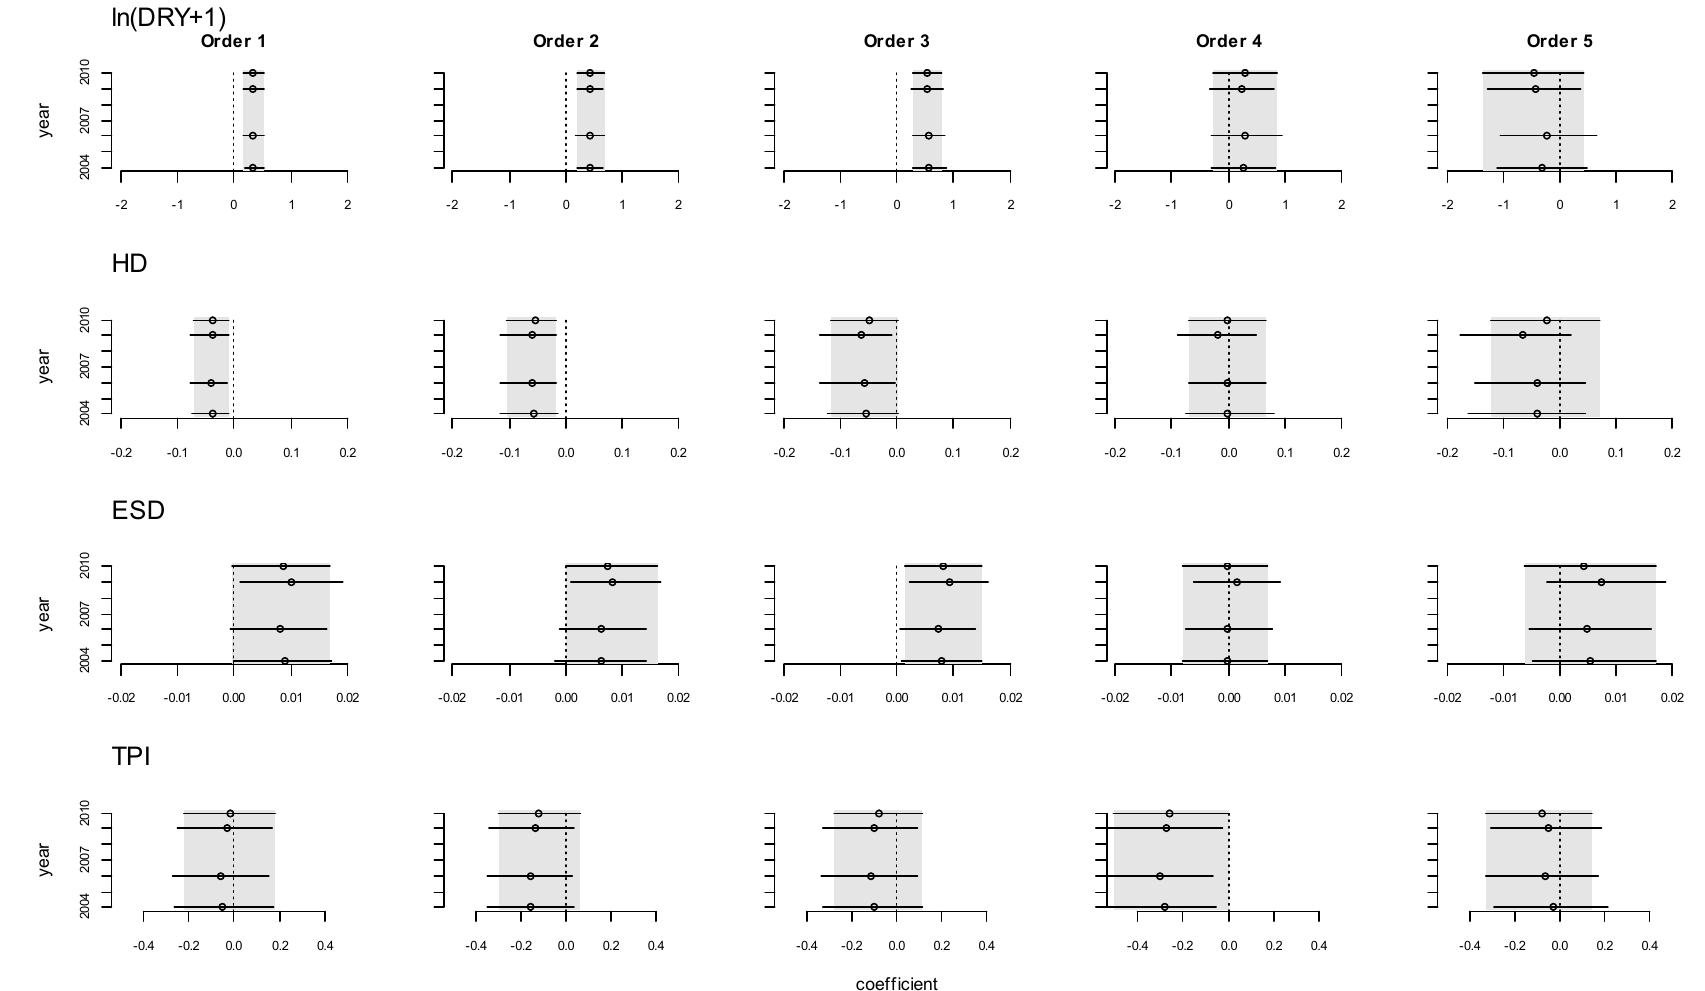
Figure A2. Coefficient and confidence intervals (calculated with bootstrap) plots of variables ln(DRY + 1), HD, ESD and TPI, Orders 1–5, for univariate Cox regressions. TSF data describe the study area age-structure as it was in 2010 (shaded rectangle, as used for analysis), 2009, 2006 and 2004.